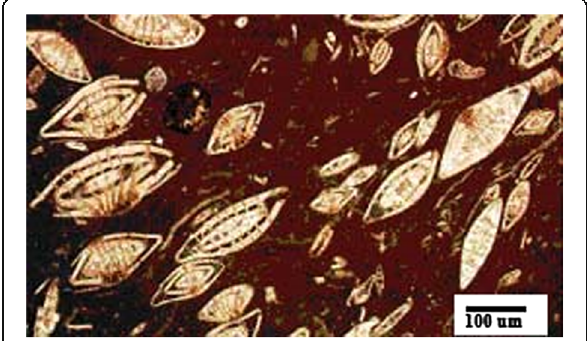
Fig. 4 Nummulitic biomicrite (wackestone/mudstone) microfacies showing Nummulite gizehensis , as well as amounts of gastropods and others scattered in micritic matrix, PPL